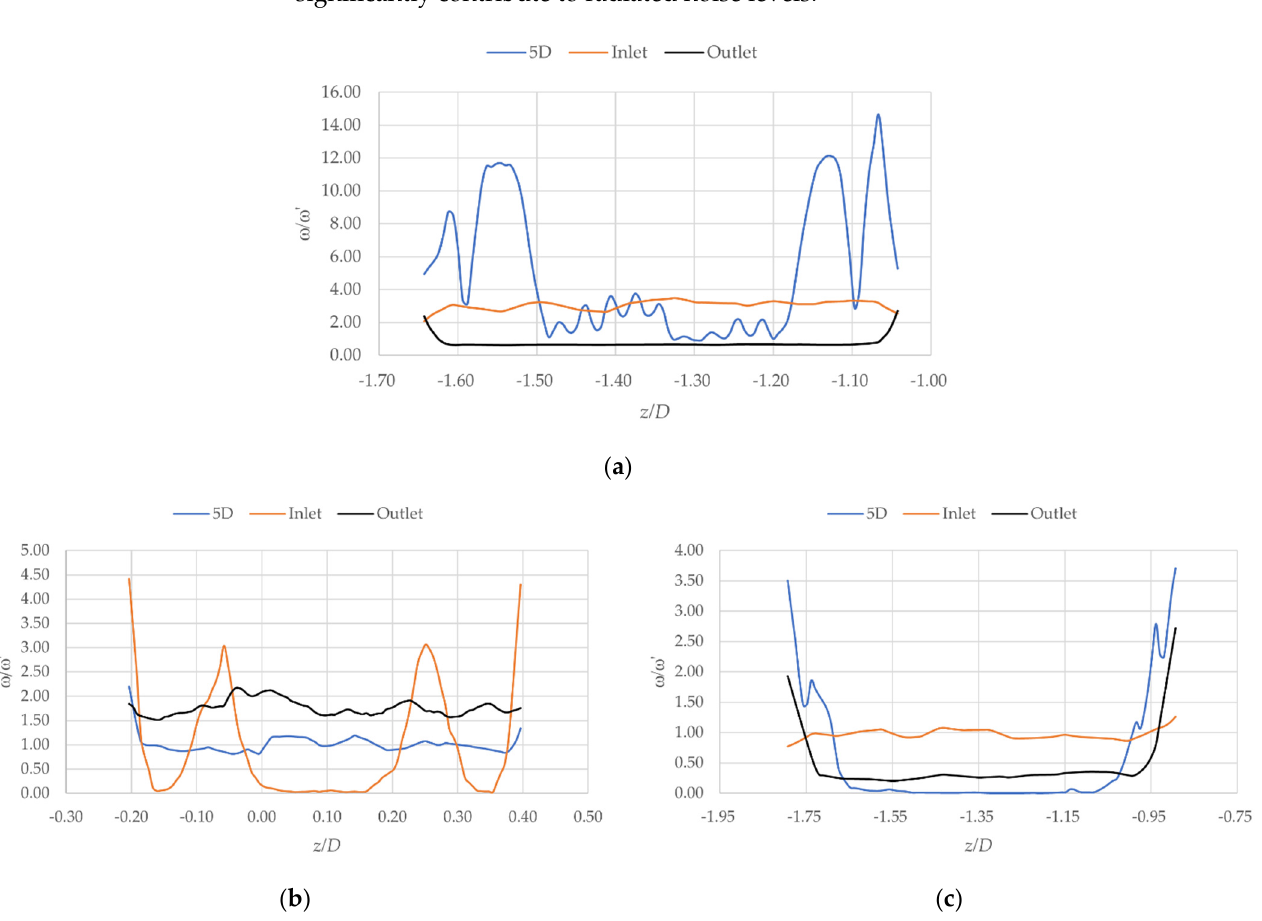
Figure 8. Relative vorticity profiles at time 0.112 s: ( a ) three blades, ( b ) four blades, and ( c ) five blades.